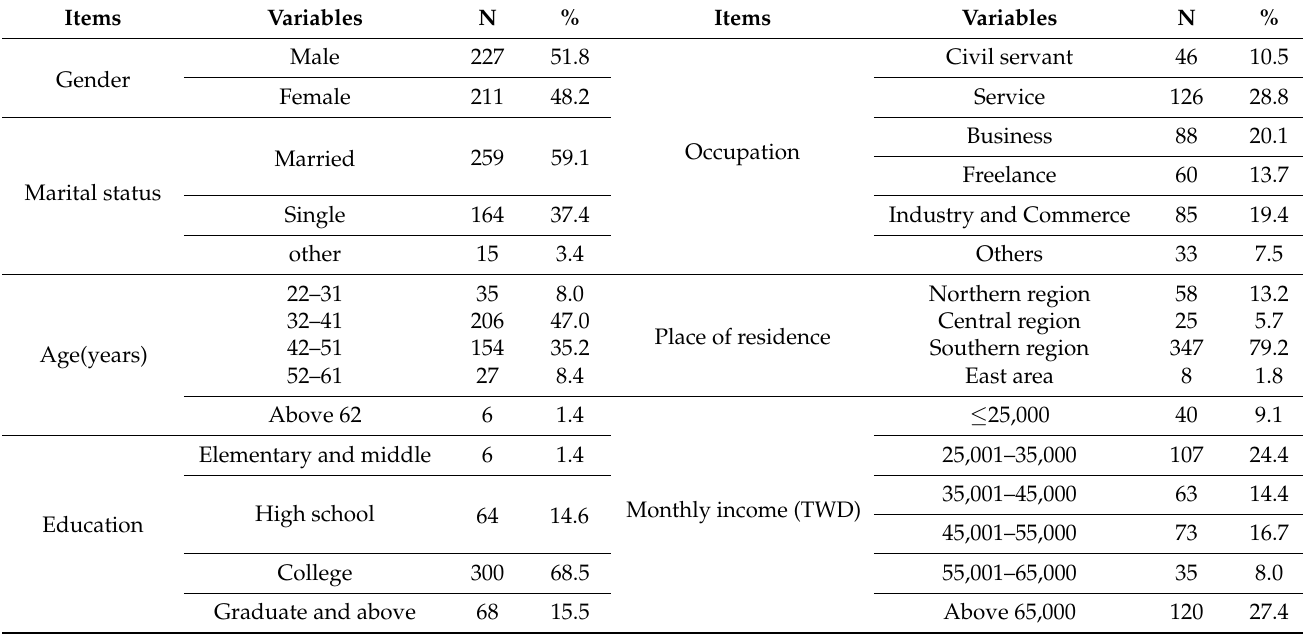
Table 1. Descriptive characteristics of the samples.